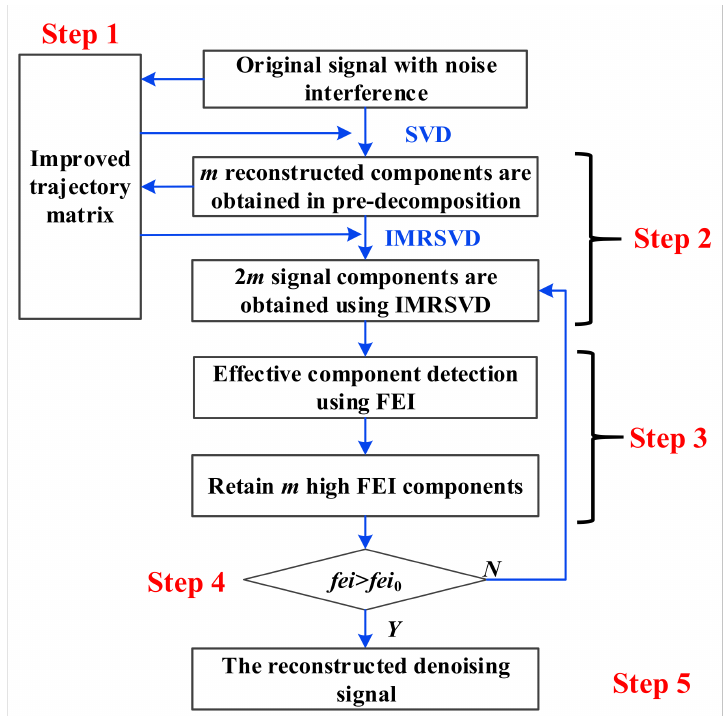
Figure 2. The flowchart of the proposed denoising